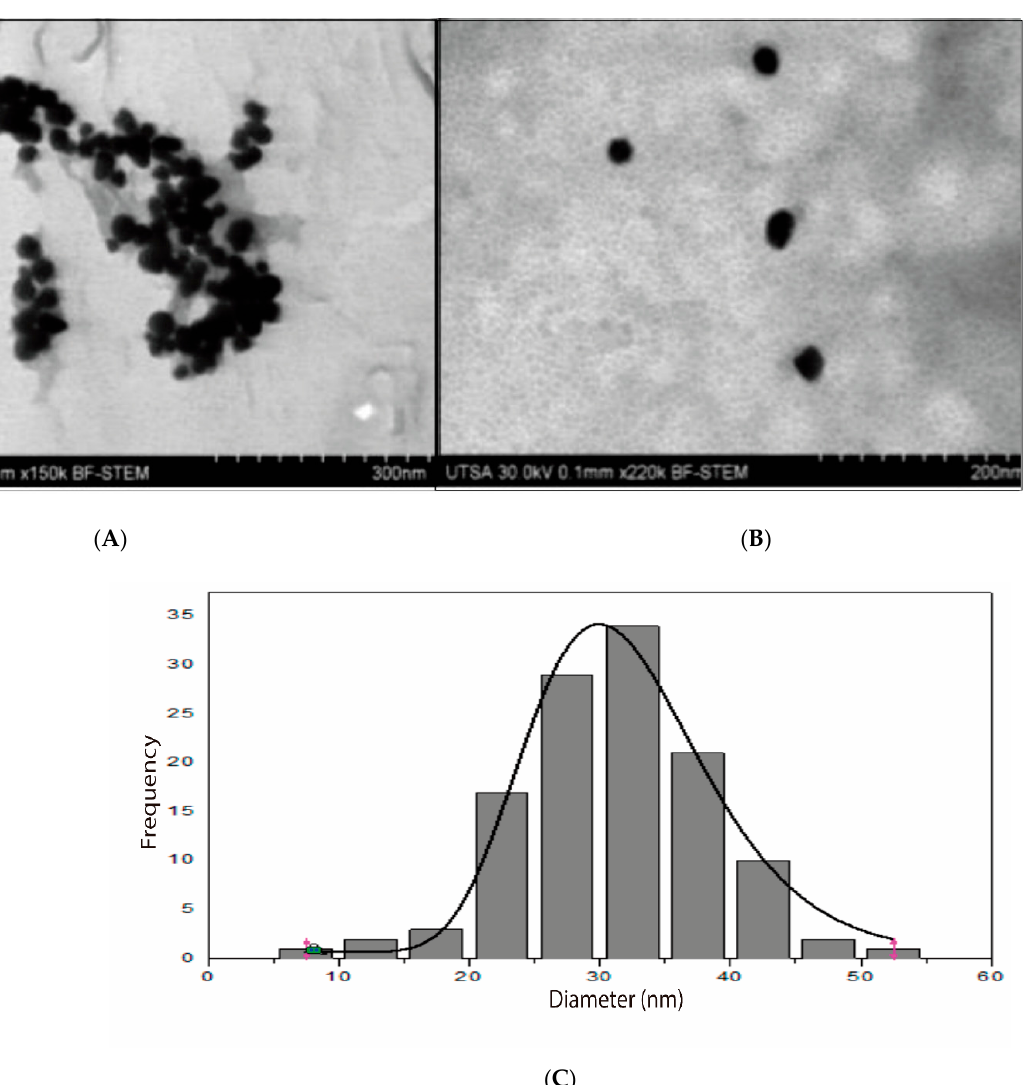
Figure 3. Left ( A ) Image of AgNPs-RR using scanning transmission electron microscopy (STEM). Right ( B ) Zoomed image of single AgNPs-RR using STEM. ( C ) Size distribution of AgNPs-RR.